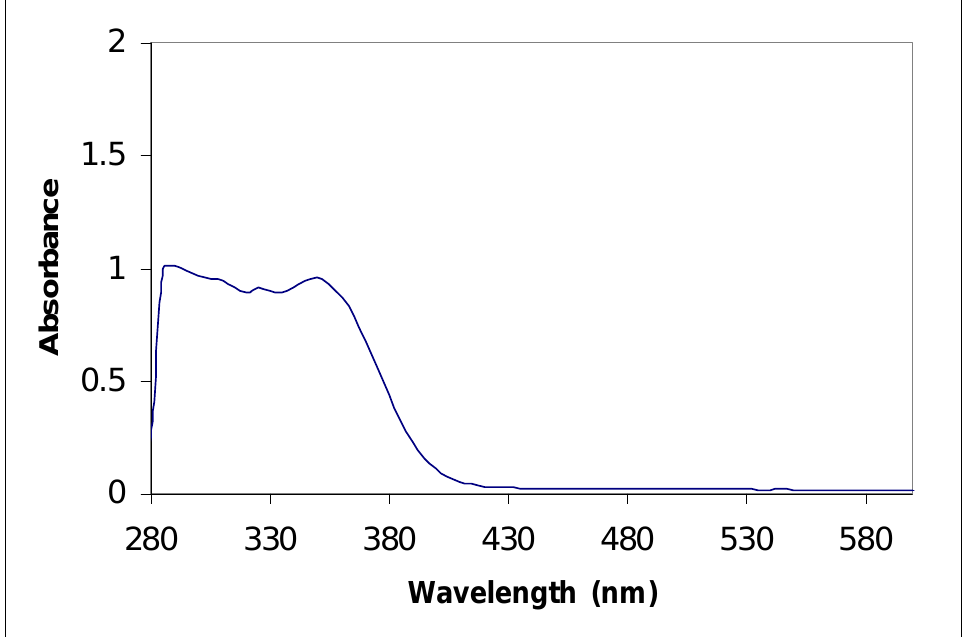
Figure 3. UV-Visible spectra of compound 8a in toluene.